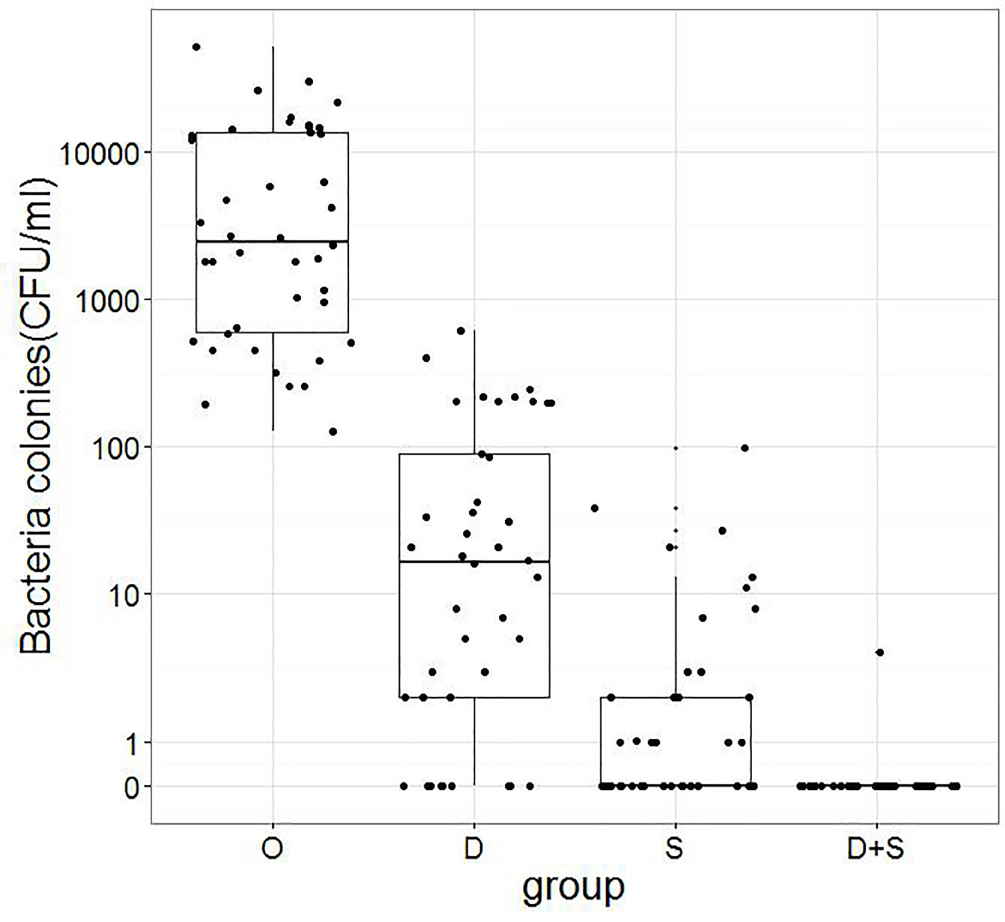
Fig. 3. Boxplot of bacterial colonies in original group (O), density gradient centrifugation group (D), swim up group (S) and combined group (D+S). Dots present individual values with a value of zero for those on the X-axis. The box- and whisker-plots report the 95th, 75th, 50th, 25th, and 5th percentiles for each